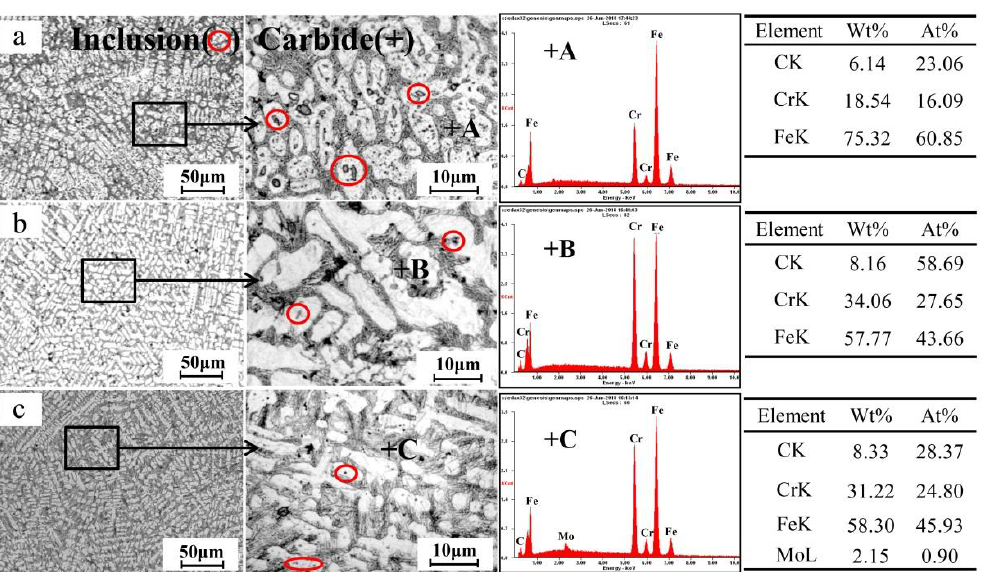
Table 6. Solid and liquid phase lines of different surfacing layers (°C).